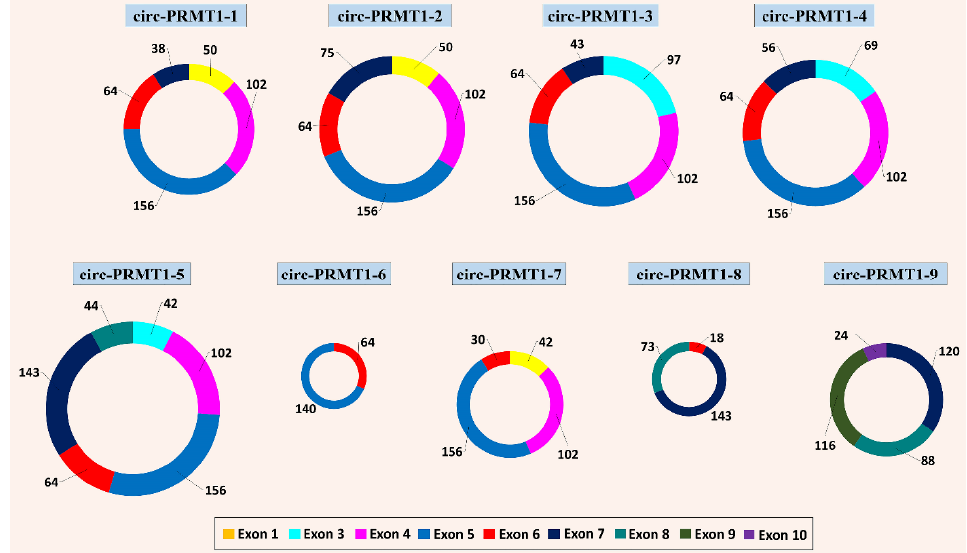
Figure 2. The 9 novel PRMT1 circRNAs that were identified, depicted in scale based on their size. The exon composition of each circRNA is shown, according to the color-coding that is shown at the bottom of the figure. The length of each exon (in nucleotides) is also depicted at the end of the respective black lines. Table 1. Features of the 9 novel PRMT1 circRNAs that were identified and their GenBank ® accession numbers. For each circRNA, the cell line cDNA(s) in which it was found expressed is shown, as well as how many and which PRMT1 exons they comprise.